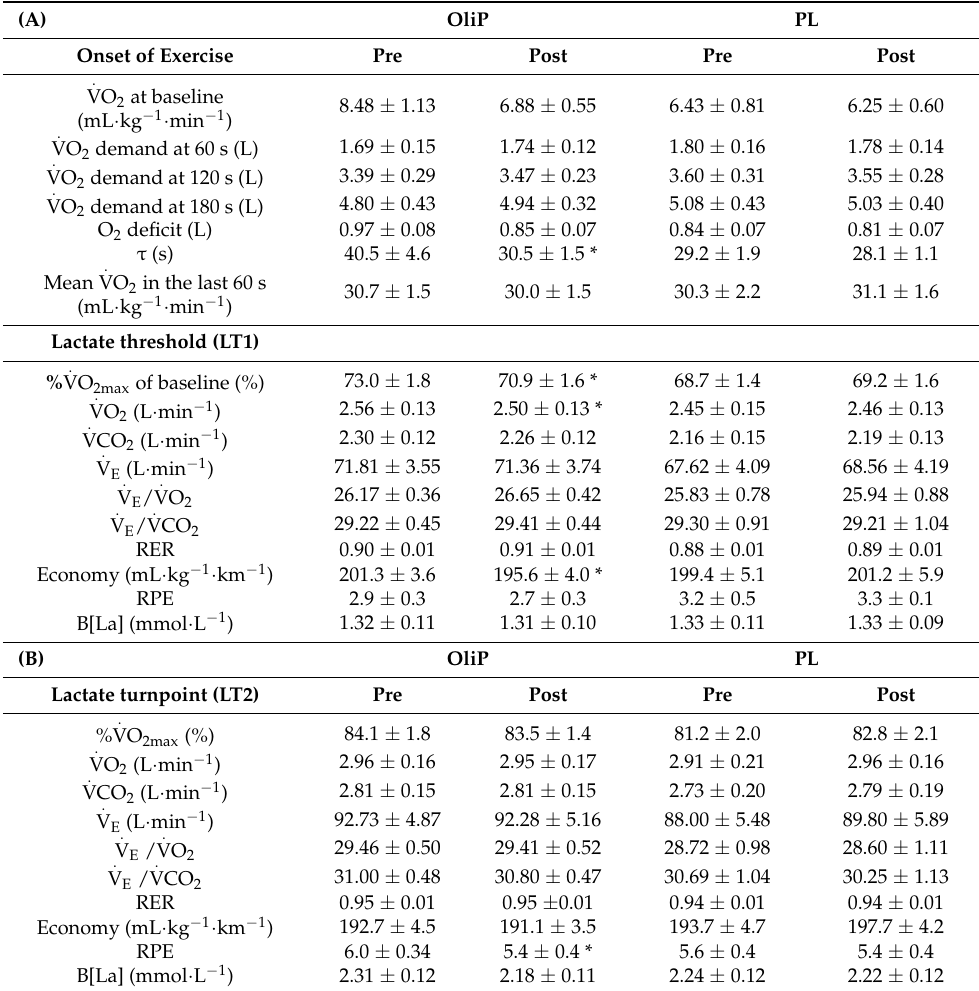
economy (time x group: F = 5.22, p = 0.031, η p2 = 0.17, Figure 3C), with a significant improvement demonstrated between visit 3 and 5 for OliP only (F = 6.82, p = 0.015, η p2 = 0.21, 95% CI range 189.80 to 207.11). Finally, it was also noted that when expressed as relative change, there was a pre- to post- intervention reduction in V̇ CO 2 within OliP ( − 1.6 ± 0.9%) compared to PL (+1.5 ± 0.9%; t = 2.33, p = 0.028, d = 0.90). Table 5. Respiratory, exercise economy, perceived exertion, and blood lactate parameters at the onset of exercise and lactate threshold (A), and lactate turnpoint (B) at visit 3 (pre-intervention) and 5 (post-intervention) interspersed with 16 consecutive days of either OliP or PL. (A) OliP PL OliP PL Onset of Exercise Pre Post Pre Post Onset of Exercise .